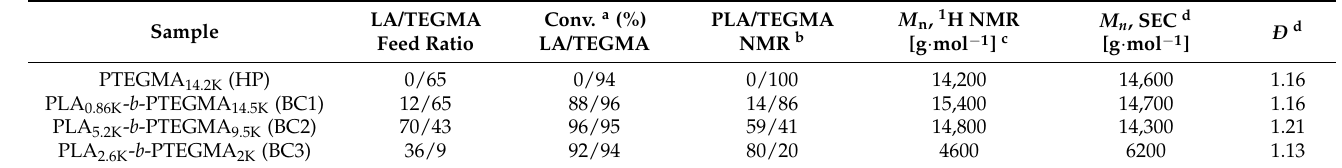
Table 1. Molecular characteristics of the PTEGMA homopolymer and PLA- b -PTEGMA block copolymers.